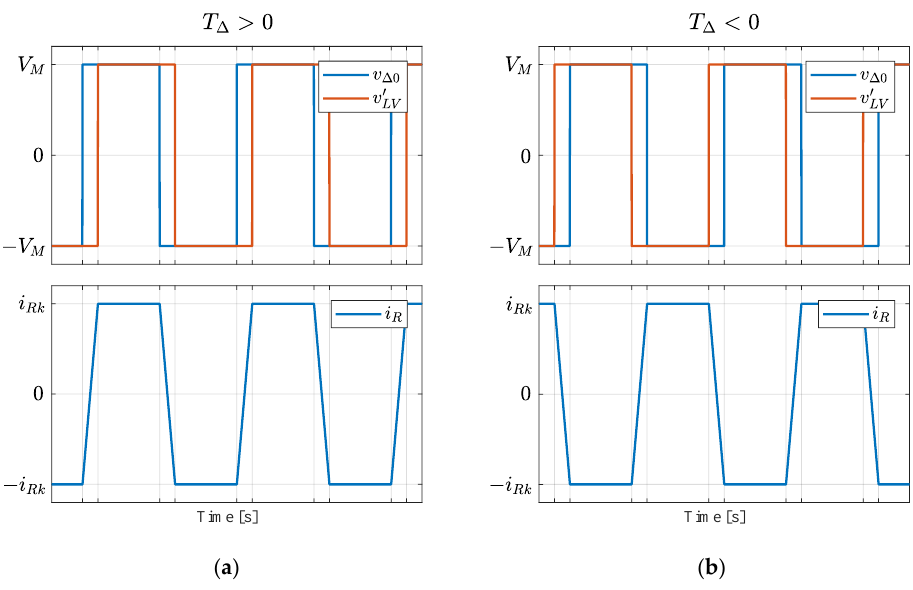
Figure 6. Converter output voltages and transformer current for positive ( a ) and negative ( b ) power.